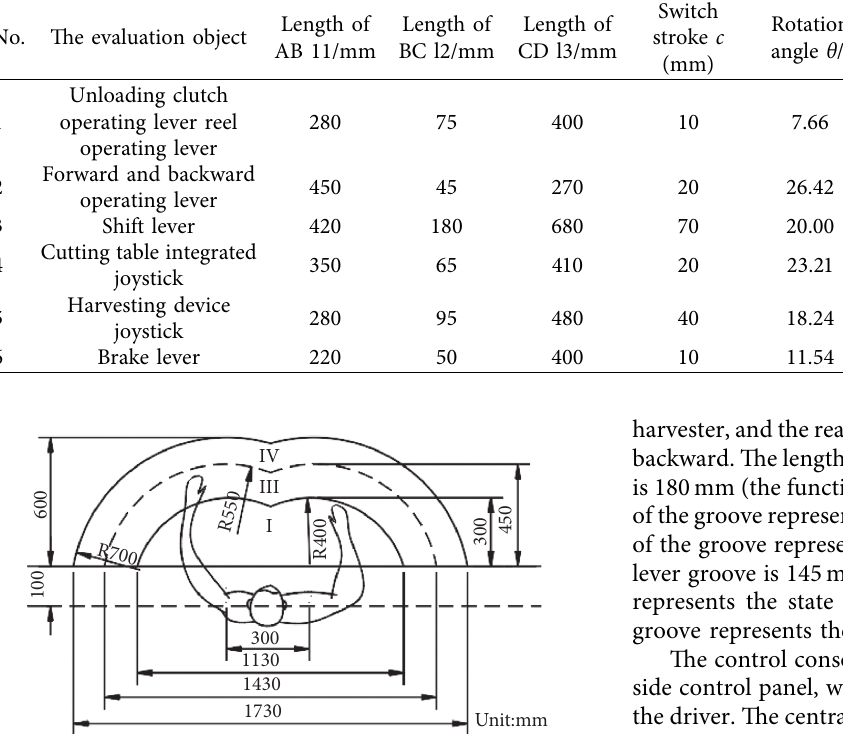
Figure 12: Schematic diagram of horizontal working area of man’s upper